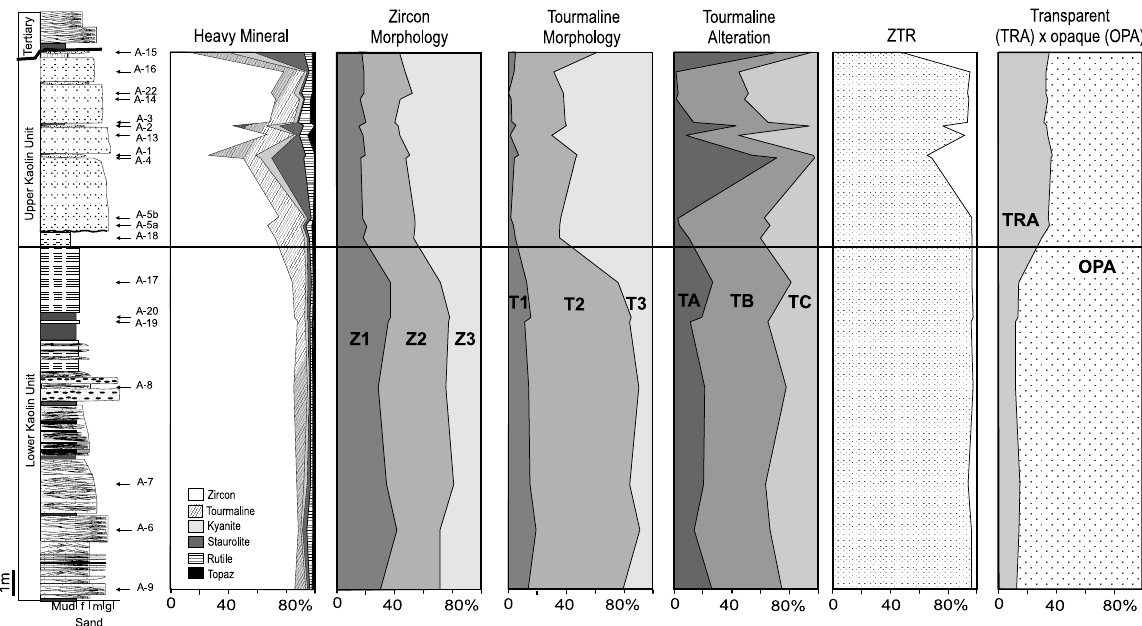
Fig. 4 – Measured lithostratigraphic profile 2 of the IRCC quarry, with frequencies of main heavy minerals and of their textures.